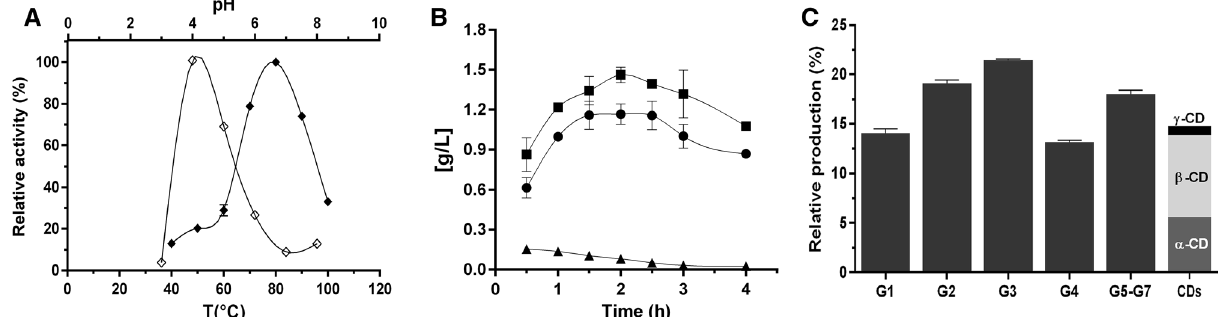
Figure 2. CldA enzymatic assay. ( A ) Effect of temperature (filled diamonds) and pH (empty diamonds) on CGTase activity. ( B ) Production of α-CD (circles), β-CD (squares) and γ-CDs (triangles) from 50 g L −1 soluble starch by the action of CldA at 75 °C and pH 4.0 for 4 h. ( C ) The relative production of end products from 50 g L −1 soluble starch after 2 h of reaction at 75 °C and pH 4.0. Note that G5-G7 is the sum of the linear oligosaccharides maltopentaose, maltohexaose, and maltoheptaose. The error bars indicate the standard deviation of three